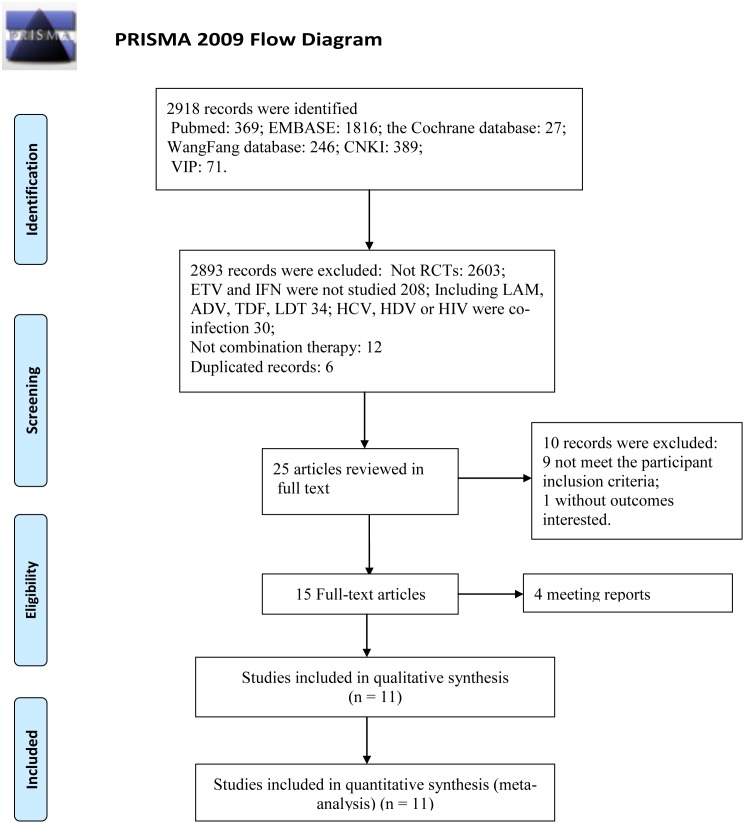
Flow Chart of Randomized Controlled Trials that were Evaluated.
From: Moher D, Liberati A, Tetzlaff J, Altman DG, The PRISMA Group (2009). Preferred Reporting Iterns for Systematic Reviews and Meta-Analyses: The PRISMA Statement. PLoS Med 6(6): e1000097. doi:10.1371/journal.pmed1000097 For more information, visit www.prisma-statement.org.